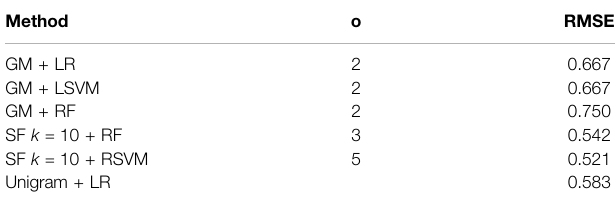
TABLE 6 | Accuracy of the best performing regression classi fi er/embedding methods if we use the predicted MMSE score to predict a transcript as AD or